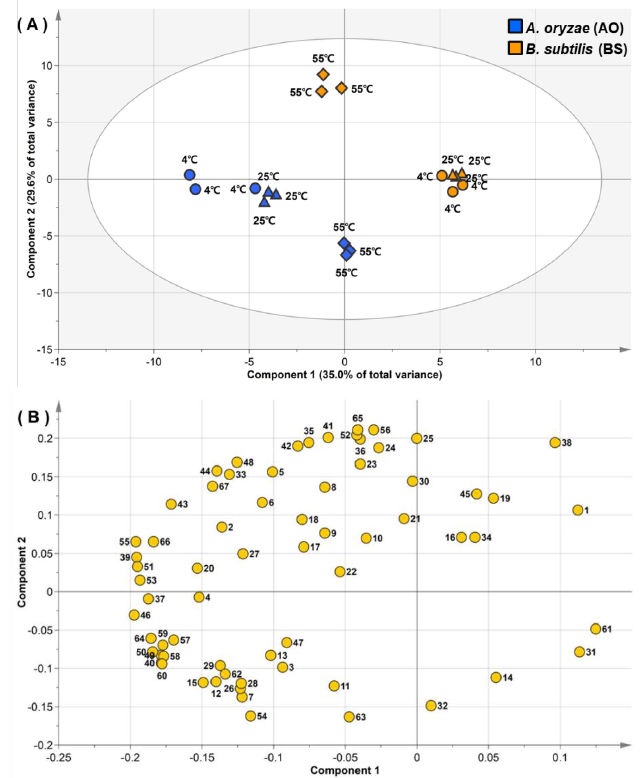
Figure 1. Score ( A ) and loading ( B ) plots of principal components 1 and 2 for the principal component analysis of hydrophilic metabolite, lipophilic metabolite, fatty acid, isoflavone, and raffinose data pertaining to Aspergillus oryzae (blue symbols) or Bacillus subtilis (yellow symbols) fermented soybeans after water extraction at 4 °C (circles), 25 °C (diamonds), and 55 °C (triangles). Plot annotation: 1, C14:0; 2, C16:0;